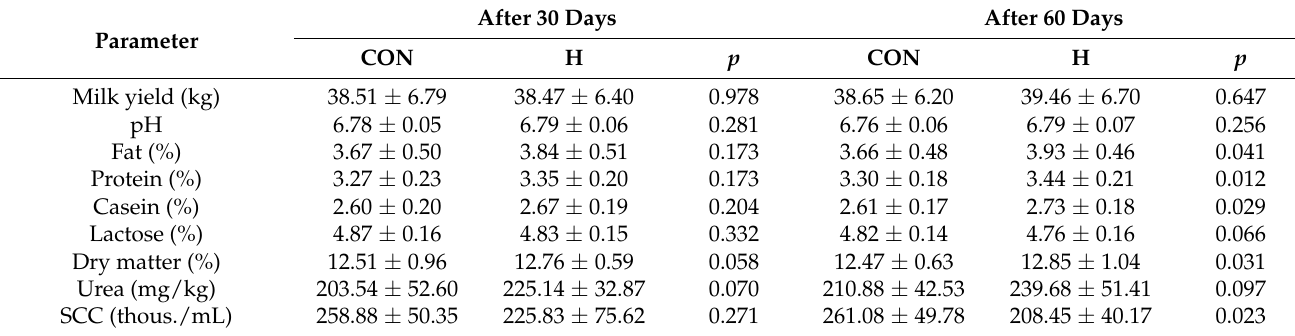
Table 2. Effect of the addition of oxyhumolite to the diet on yield and milk parameters (Mean ± SD). After 30 Days After 60 Parameter